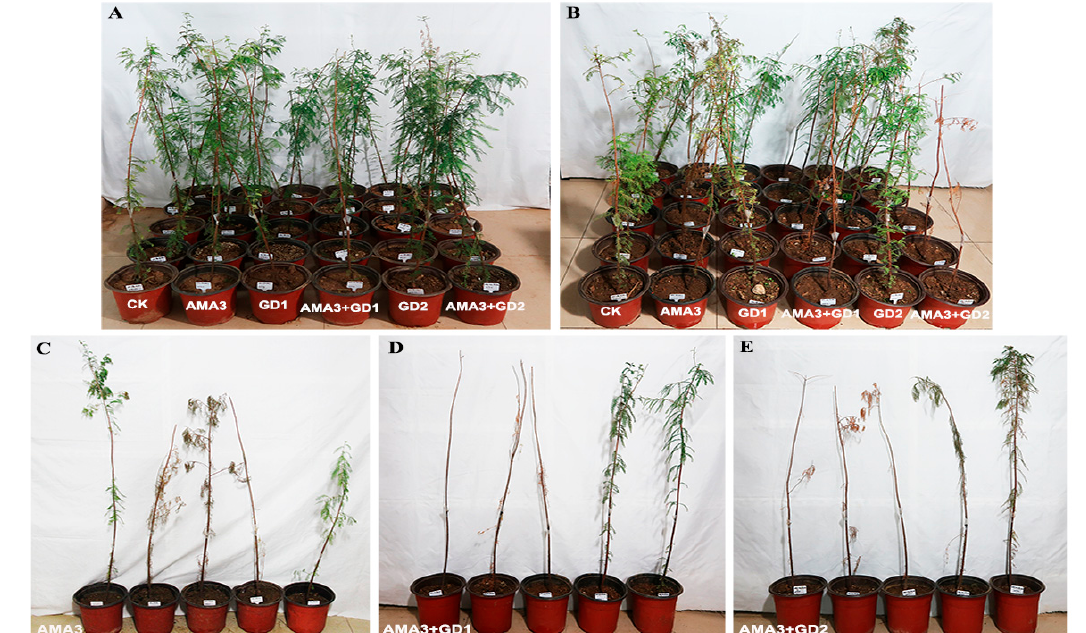
Figure 4. Symptoms of potted seedlings of Larix kaempferi ( L. kaempferi ) after inoculation with Bursaphelenchus xylophilus , B. xylophilus treated with the bacterium from the body of the nematode (GD1), and B. xylophilus treated with the endophytic bacterium of P. massoniana (GD2). Each treatment of this experiment had five saplings. ( A ) The symptoms of L. kaempferi after inoculation for one day with AMA3, AMA3 treated with GD1, and AMA3 treated with GD2. ( B ) The symptoms of L. kaempferi after inoculation for 45 days with AMA3, AMA3 treated with GD1, and AMA3 treated with GD2. ( C – E ) The symptoms of L. kaempferi after inoculation for 45 days with AMA3 ( C ), AMA3 treated with GD1 ( D ), AMA3 treated with GD2 ( E ). Control group (CK) was only inoculated with 2 mL of sterile deionized water. Table 4. Disease incidence and disease index (DI) of Larix kaempferi inoculated with di ff erent treat- ments of pine wood nematodes. CK—control group.